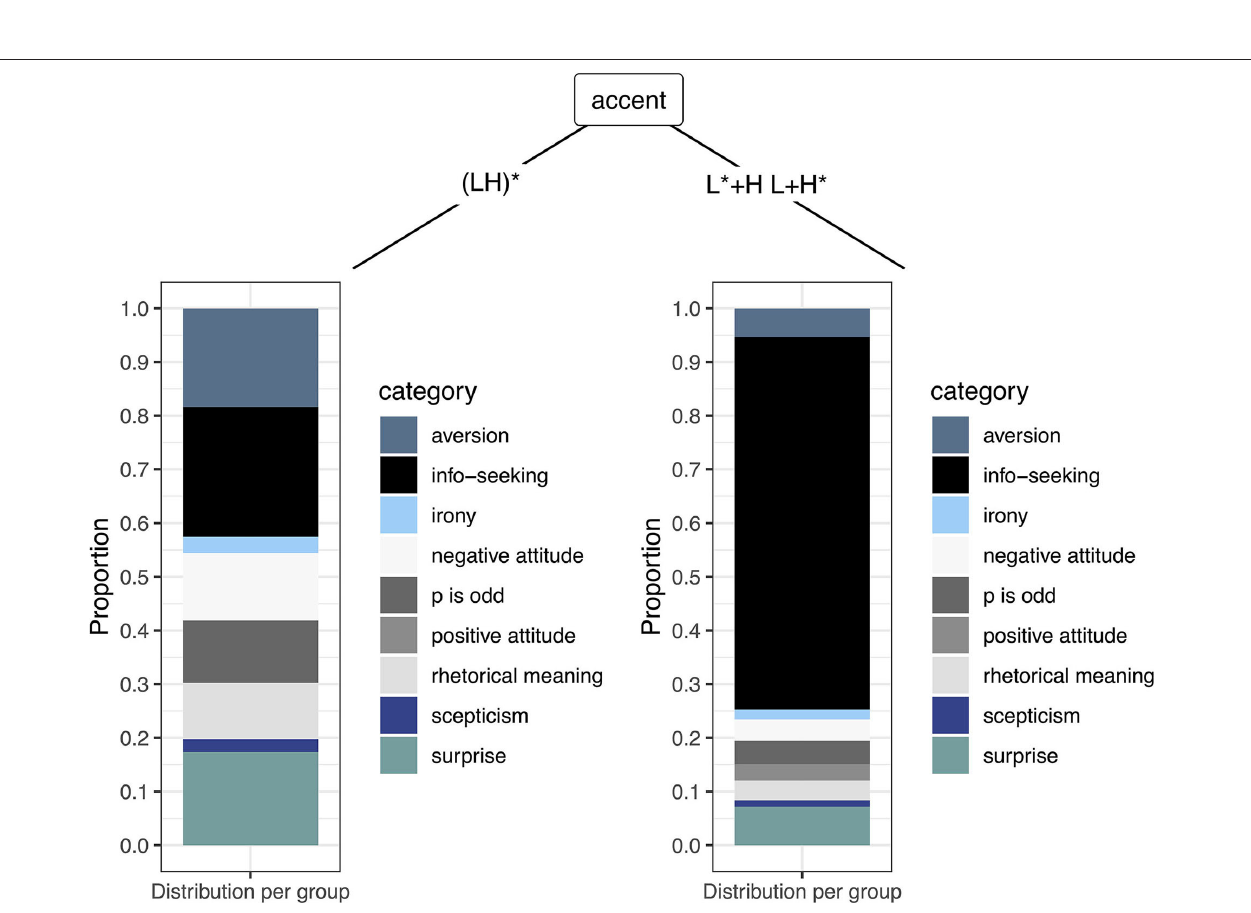
FIGURE 6 | Visualization of the Conditional Inference Tree. The predicted categories are shown in form of a stacked bar plot. The only split in the CTree was caused by intonation condition ( p < 0.001), separating the (LH)* accent (left) from the GToBI accents L + H* and L* + H (right).